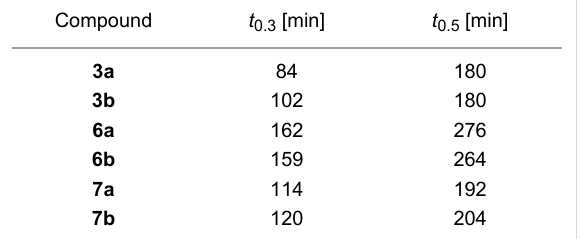
Table 1: Half-times ( t 0.5 ) and t 0.3 of deprotection for 3a , b , 6a , b and 7a , b